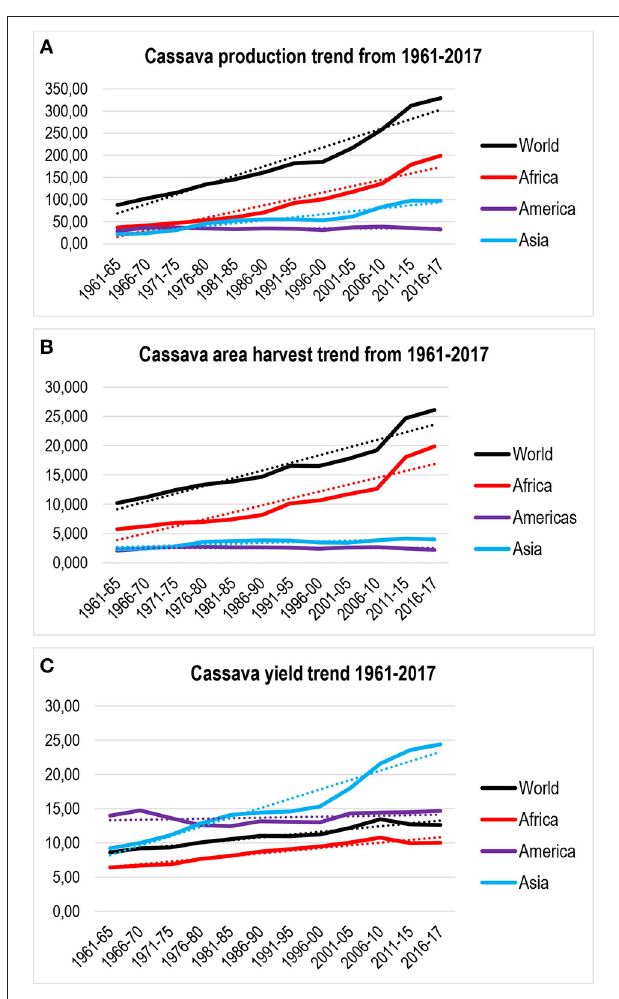
FIGURE 1 | Cassava production (A) area harvest (B) and yield (C) trend from 1961 to 2017 (Source: FAOSTAT,